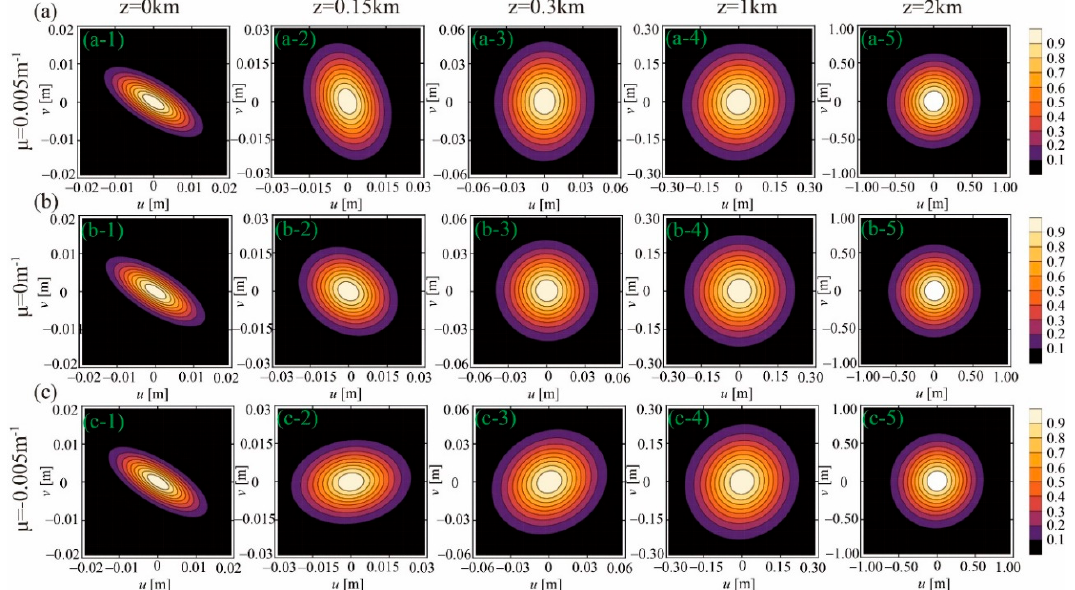
Figure 2. Normalized spectral density (contour graph) of a TAGSM beam at several propagation distances z in oceanic turbulence ( ω = − 2.5, ε = 10 − 7 m 2 /s 3 , χ T = 10 − 8 K 2 /s) for di ff erent values of the initial twist factor. ( a ) µ = 0.005 m − 1 ; ( b ) µ = 0 m − 1 ; ( c ) µ = − 0.005 m − 1 .